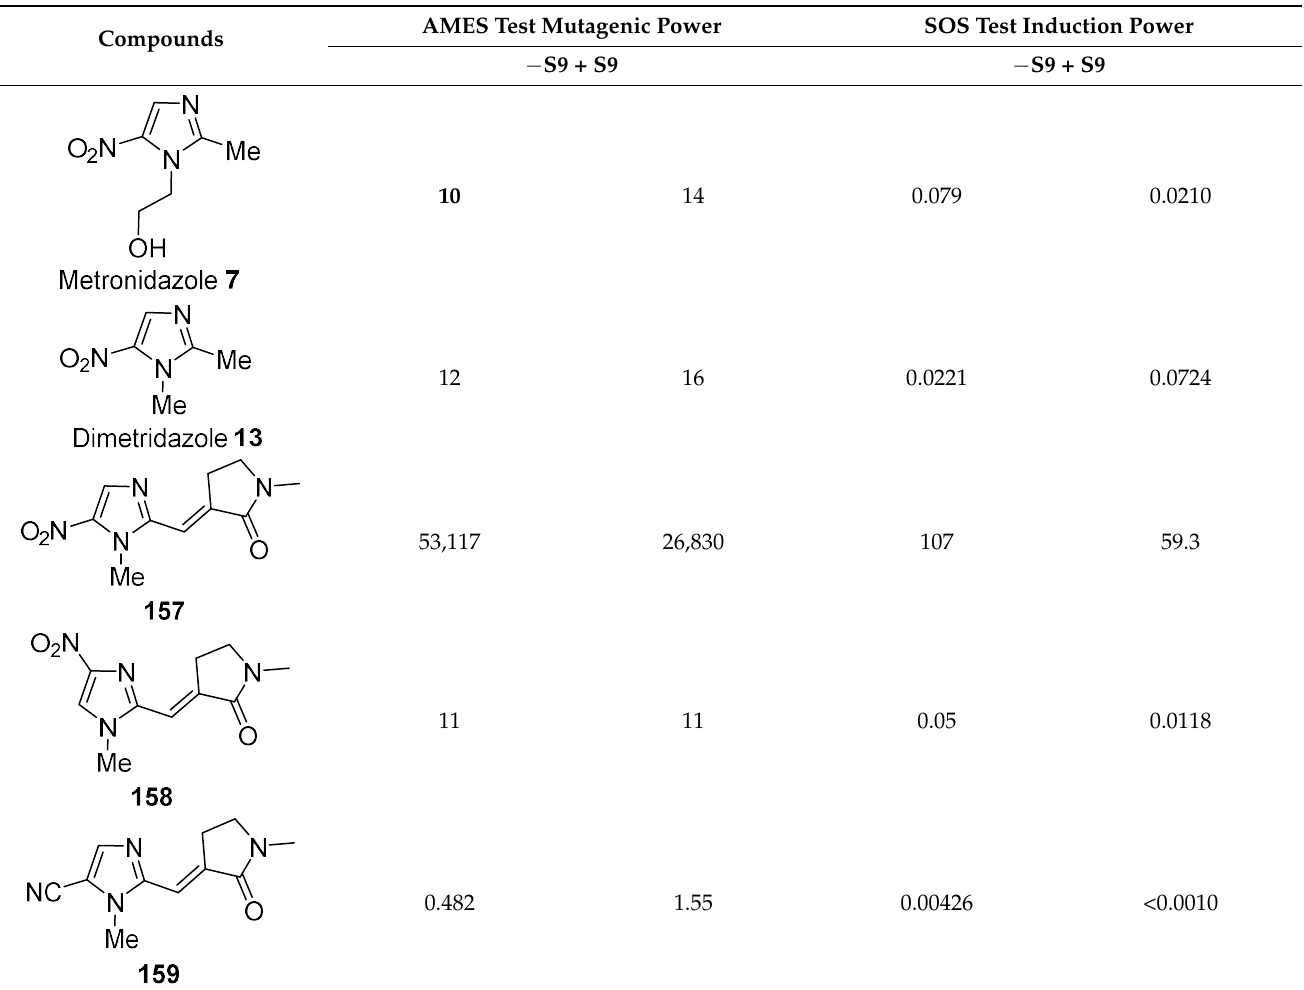
Table 5. Ames test and SOS Chronotests for Metronidazole 7 and Dimetridazole 13 , 157 , 158 and 159 . Compounds